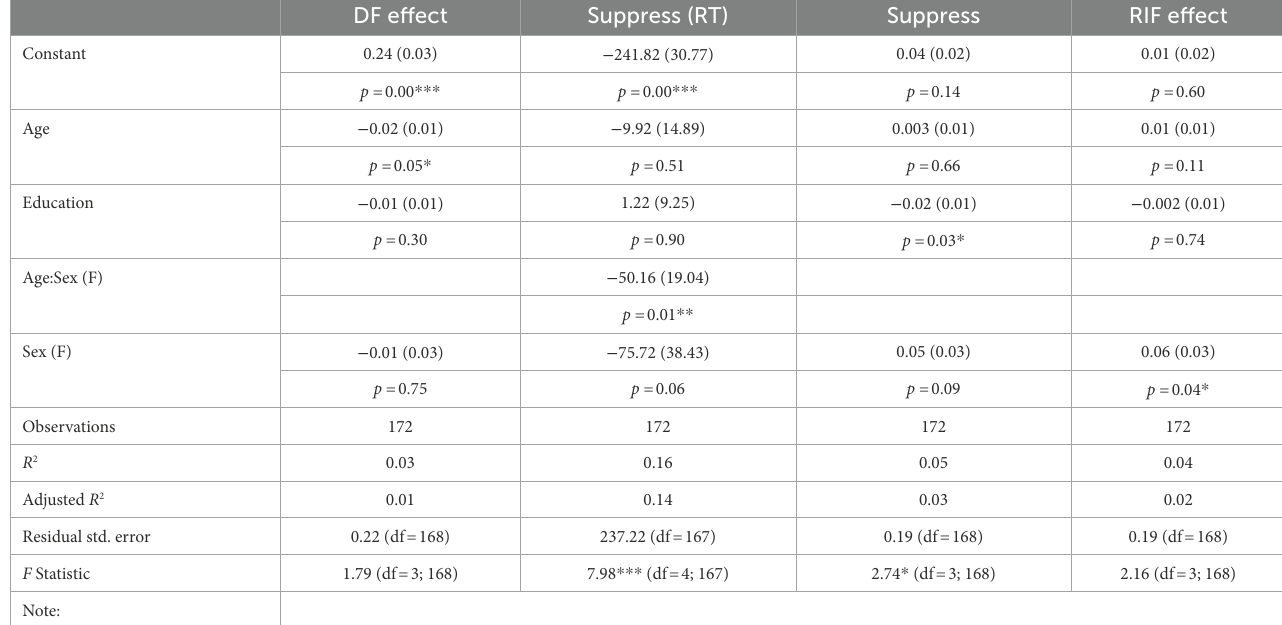
TABLE 2 Summary of the linear regression showing relation between individual scores on the three tasks and sociodemographic